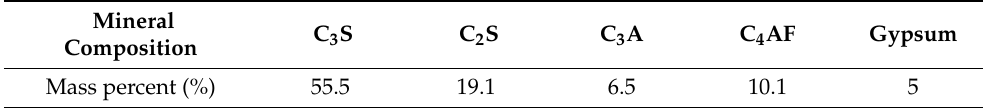
Table 5. Chemical composition of P.O.42.5 ordinary portland cement. Table 6. Mineral composition of P.O.42.5 ordinary portland